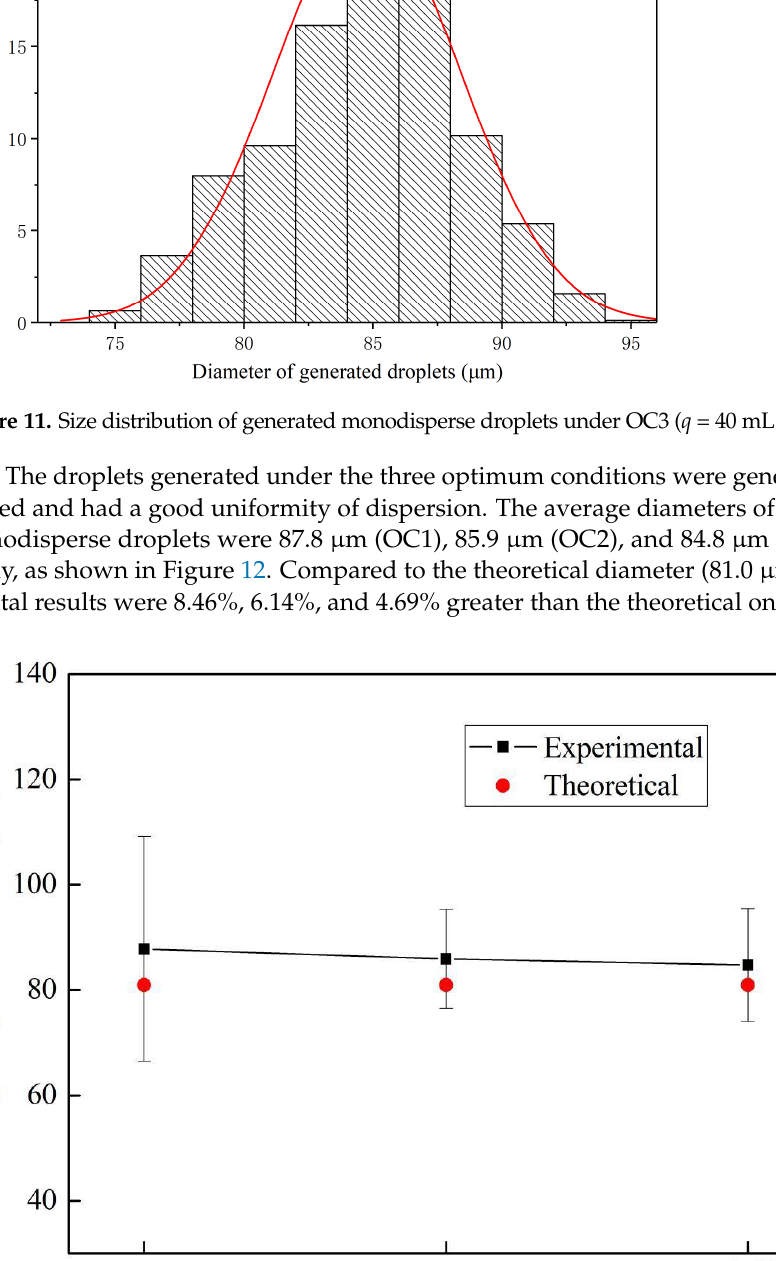
Figure 10. Size distribution of generated monodisperse droplets under OC2 ( q = 30 mL/h, f = 30 kHz).